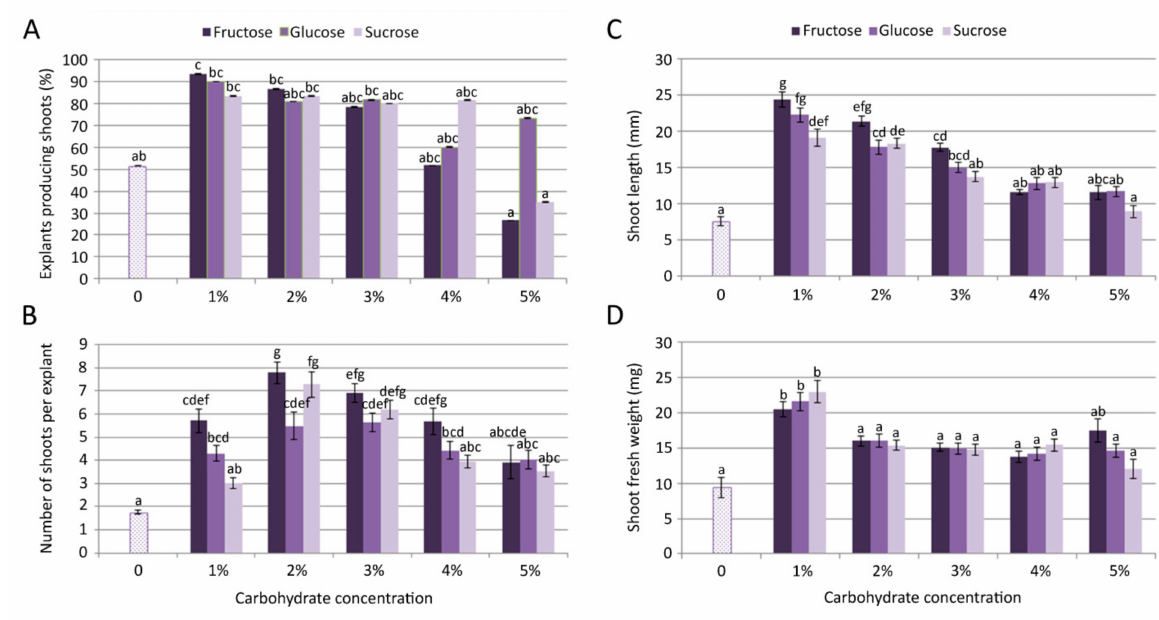
Figure 1. Effect of carbon source on Clinopodium pulegium shoot multiplication: frequency of shoot induction ( A ), number of shoots per explants ( B ), shoot length ( C ) and shoot fresh weight ( D ) after 28 days of culture. Values represent means ± SE, n = 60. Means within the same histogram marked with different letters are significantly different according to Tukey’s HSD test at p ≤